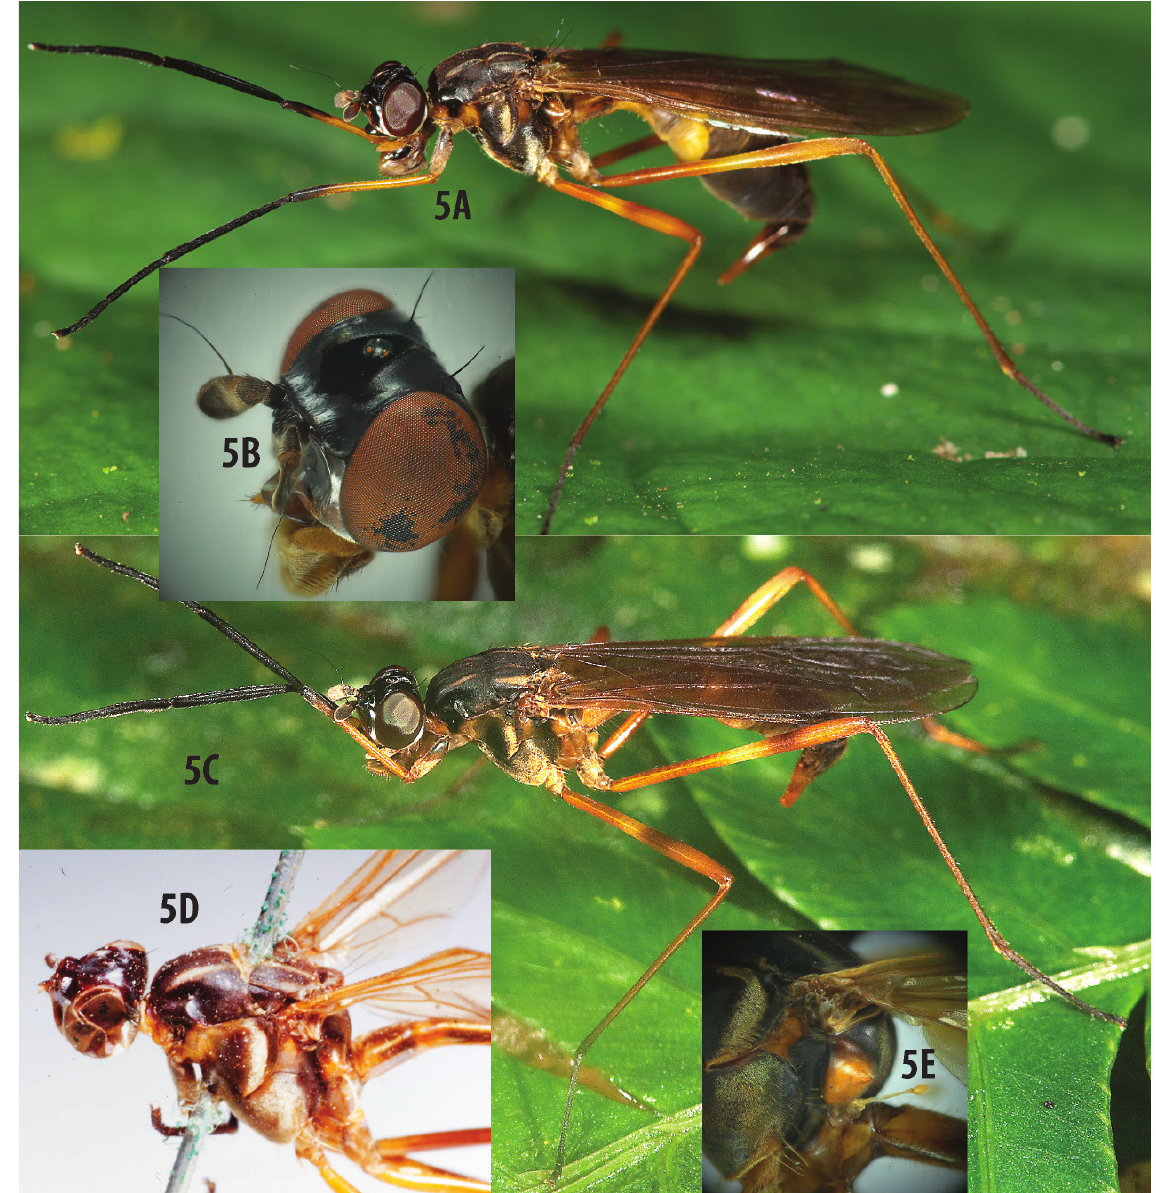
Fig. 5. Mesoconius auristrigatus Enderlein, 1922, external characters. A , C . Living ♀♀, Ecuador. B . Head, ♀. D . Holotype, ♀, MNBG. E . Pleuron and base of abdomen to show orange